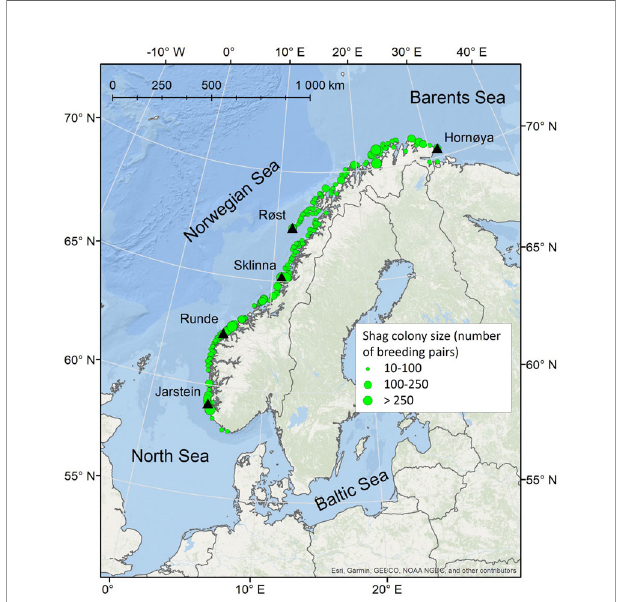
FIGURE 1 | Overview map showing the locations of the fi ve shag study colonies in Norway (black triangles). Green points indicate the location and approximate size of all shag colonies registered through the national seabird monitoring programme in